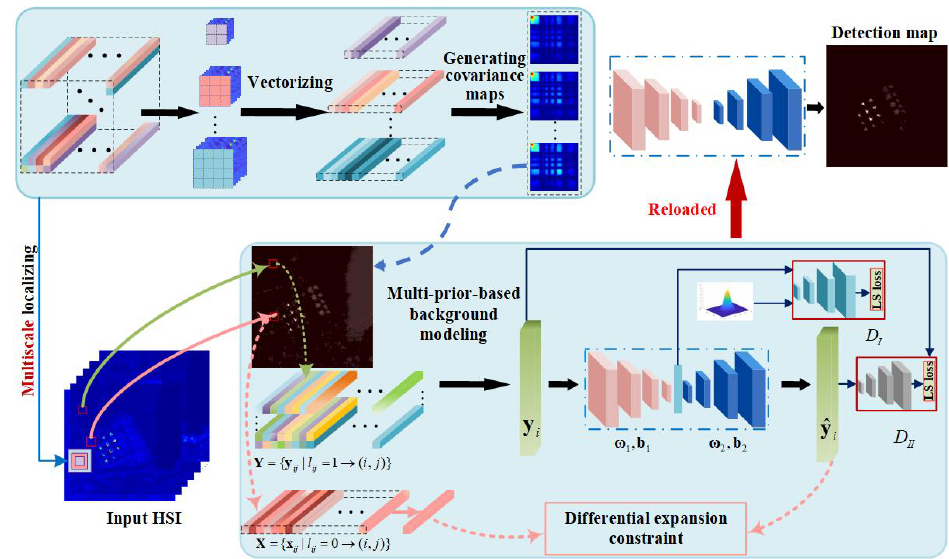
Figure 1. Flowchart of the detection algorithm based on MPN, including covariance maps generation, multi-prior-based background modeling, and differential expansion constraint-imposed